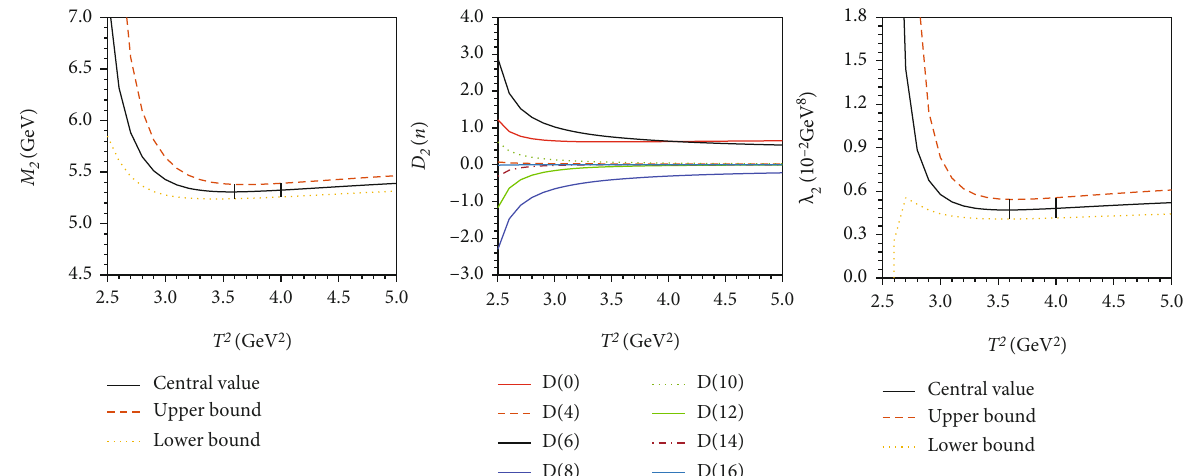
− T 2 for (a), dashed curve is drawn from the upper values of the input parameters and dotted : M 2 2 ð n Þ − T 2 for (b); λ − T 2 for (c), dashed curve is drawn from the upper values of the input parameters 2 2